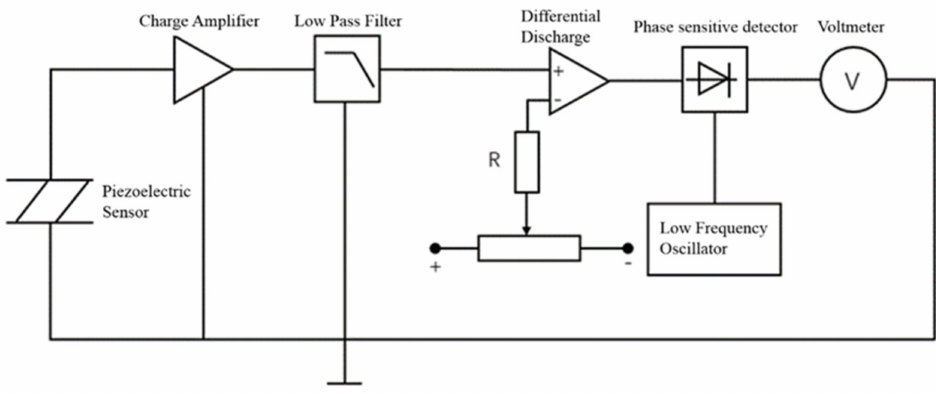
Figure 6. Experimental circuit diagram of piezoelectric sensor.